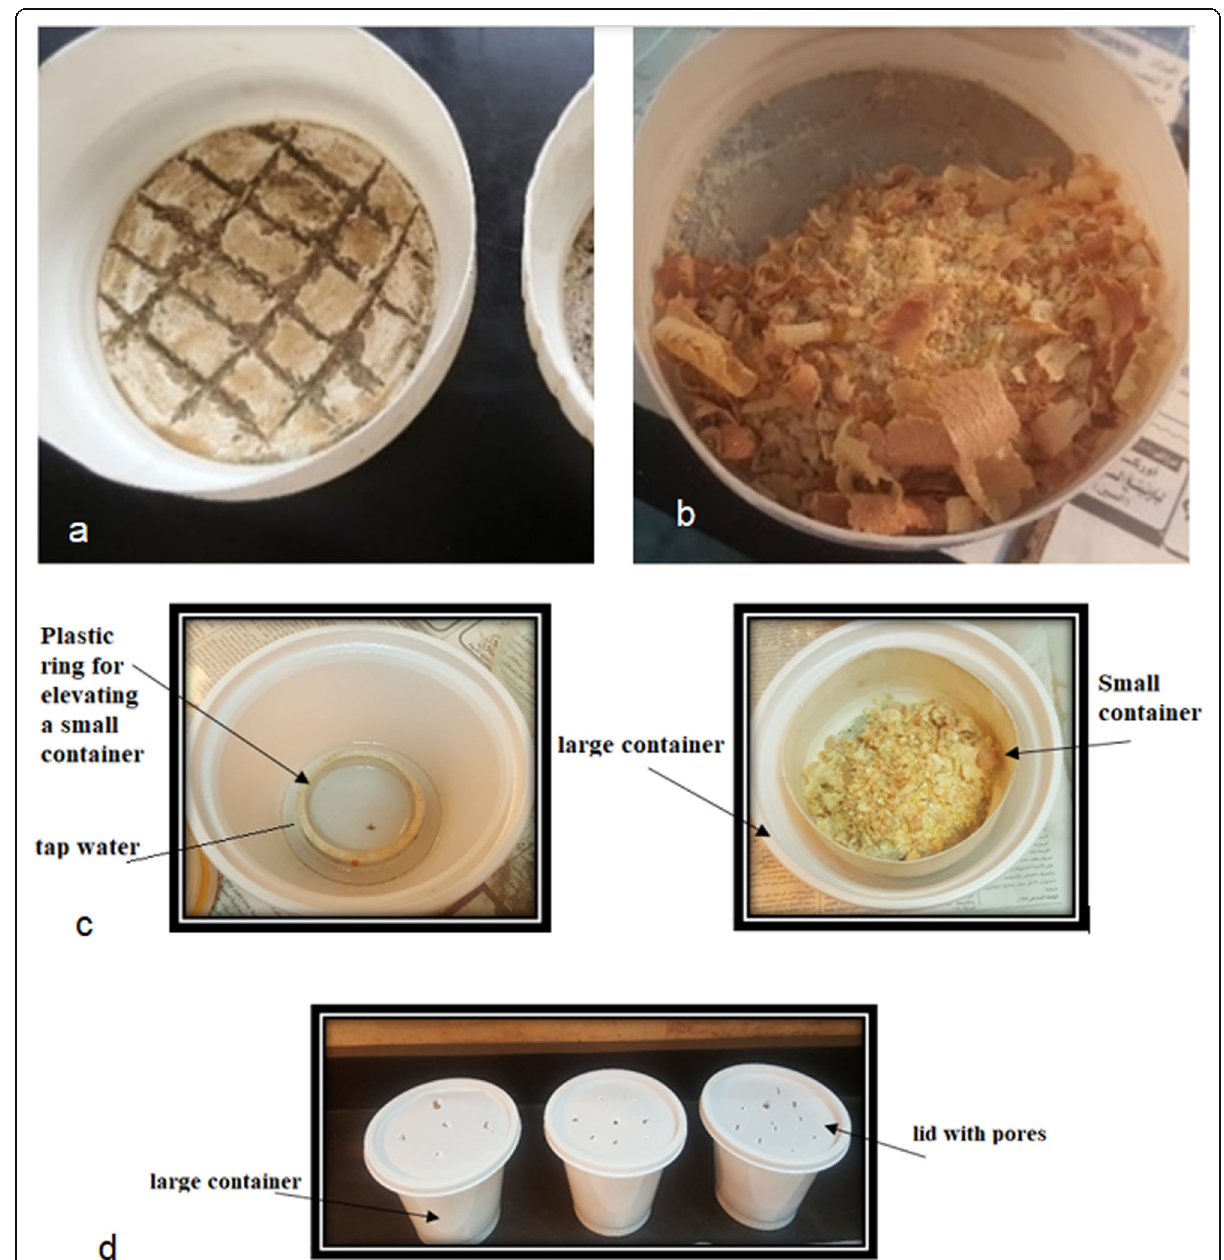
Fig. 1 Dust mites culture media: a Plastic culture container with a cement base. b Culture media and mites. c Large and small containers. d Ventilation pores in larger containers